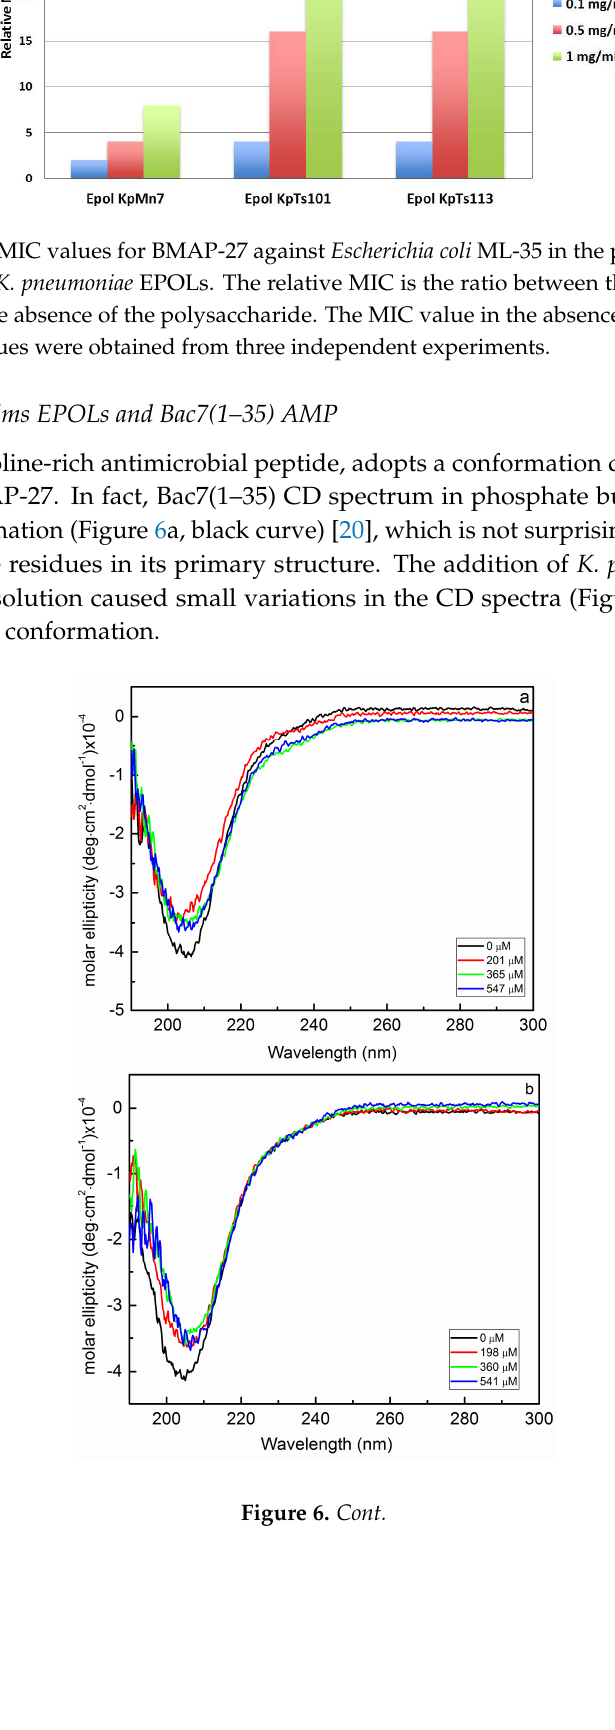
Figure 5. Relative MIC values for BMAP-27 against Escherichia coli ML-35 in the presence of